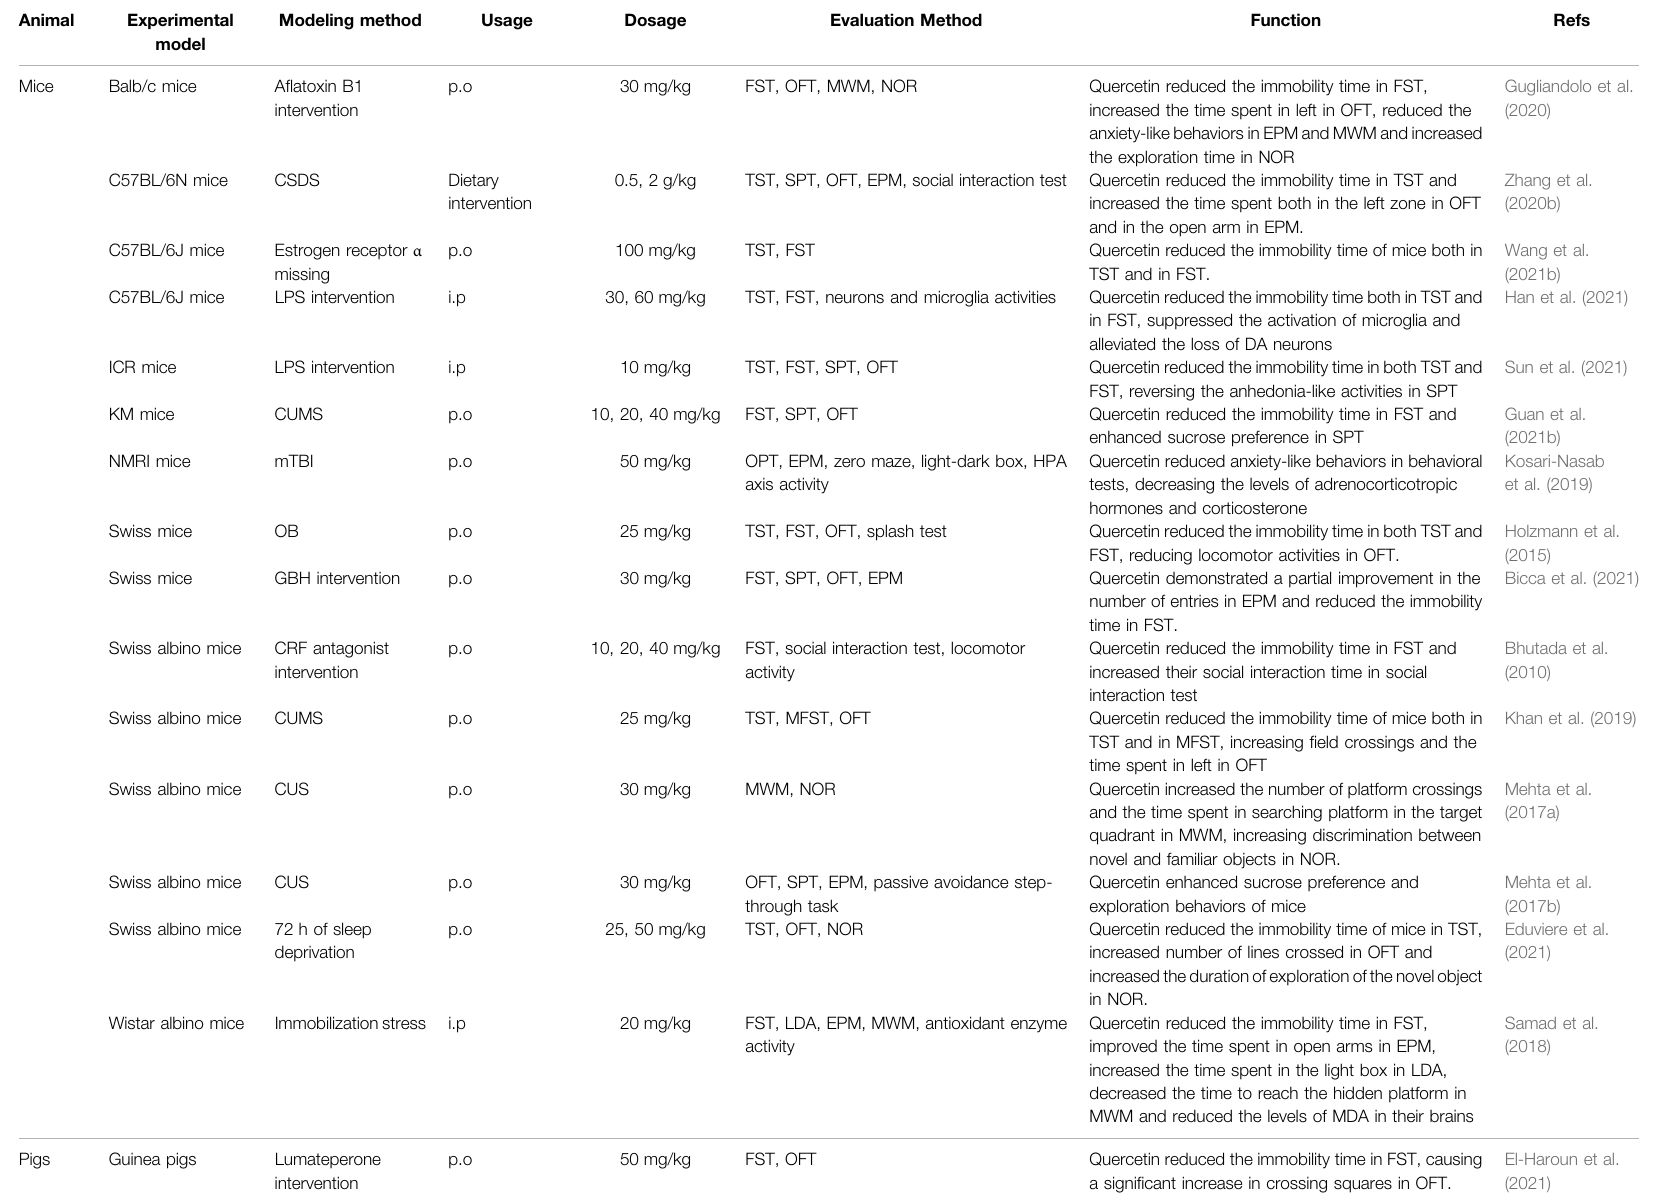
TABLE 1 | The in vivo studies on the antidepressant effects of